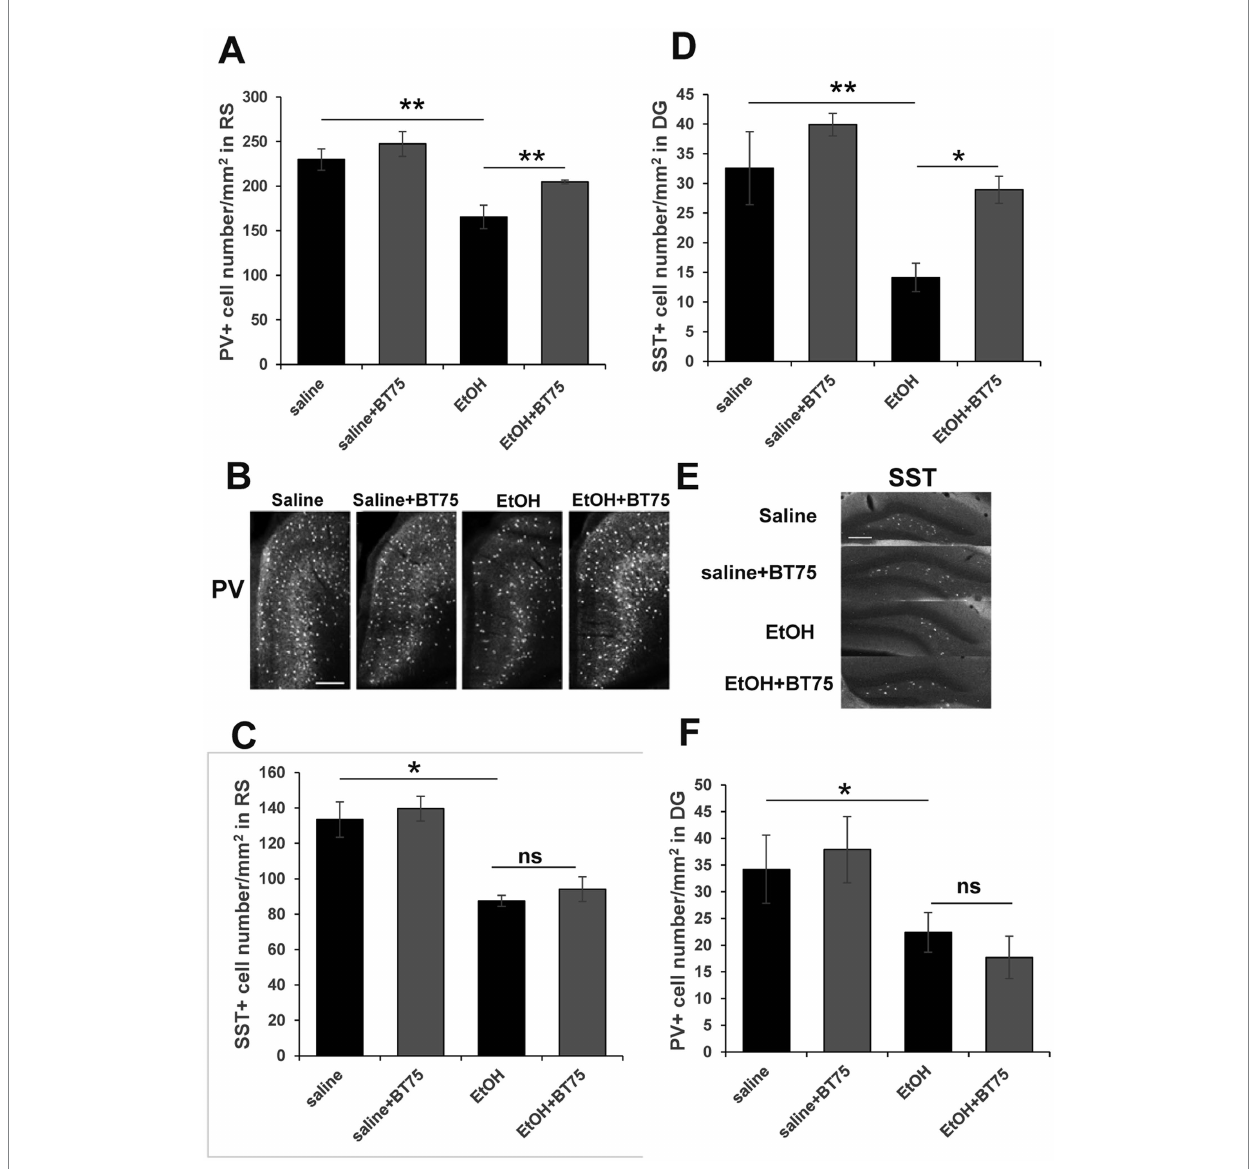
FIGURE 7 Post-ethanol treatment with BT75 attenuates P7 ethanol-induced GABA neuron deficits at P30. Three days after saline/ethanol injections at P7, mice were injected with BT75 (10 mg/kg) or the vehicle (10% DMSO) by ip once a day for 3 days. Then at P30, mice were perfusion-fixed and the brain sections were immunolabeled using anti-PV or anti-SST antibody. (A) PV+ cell density in RS. ** p < 0.01 and * p < 0.05 by a Fisher’s LSD post-hoc test after one-way ANOVA. n = 4. (B) Representative images used for A . (C) SST+ cell densities in RS. * p < 0.05 and ns not significant by a Fisher’s LSD post-hoc test after one-way ANOVA. n = 4. (D) SST+ cell densities in DG. ** p < 0.01 and * p < 0.05 by a Tukey post-hoc test after one-way ANOVA. n = 4. (E) Representative images used for D . (F) PV+ cell densities in DG. * p < 0.05 and ns not significant by a Fisher’s LSD post-hoc test after one-way ANOVA. n = 4. In B and E , scale bar = 200 μ